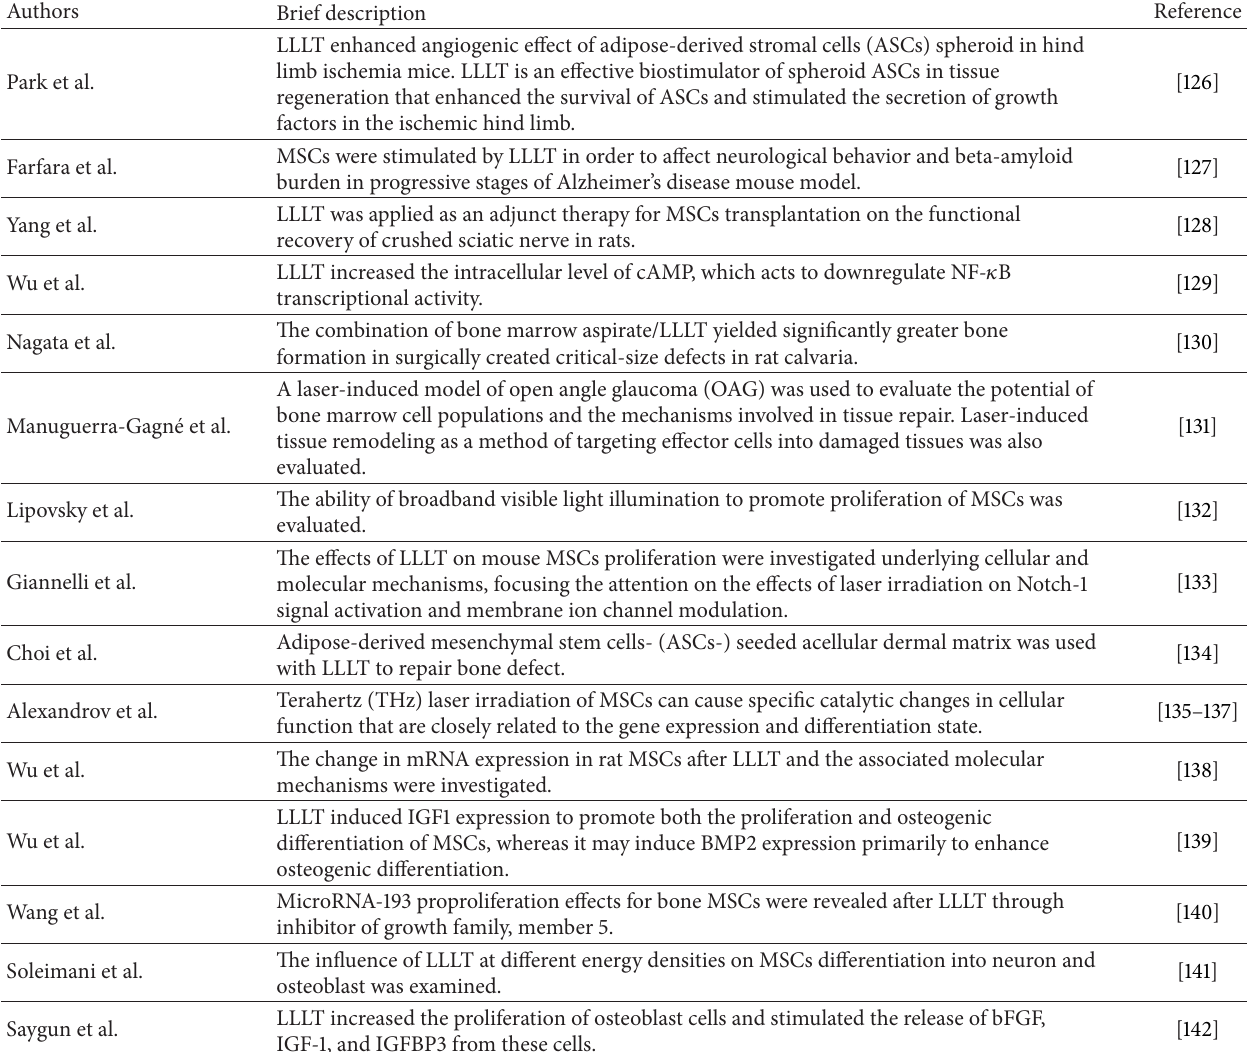
Table 1: The effect of LLLT on the MSCs proliferation and differentiation (literatures published in recent 3